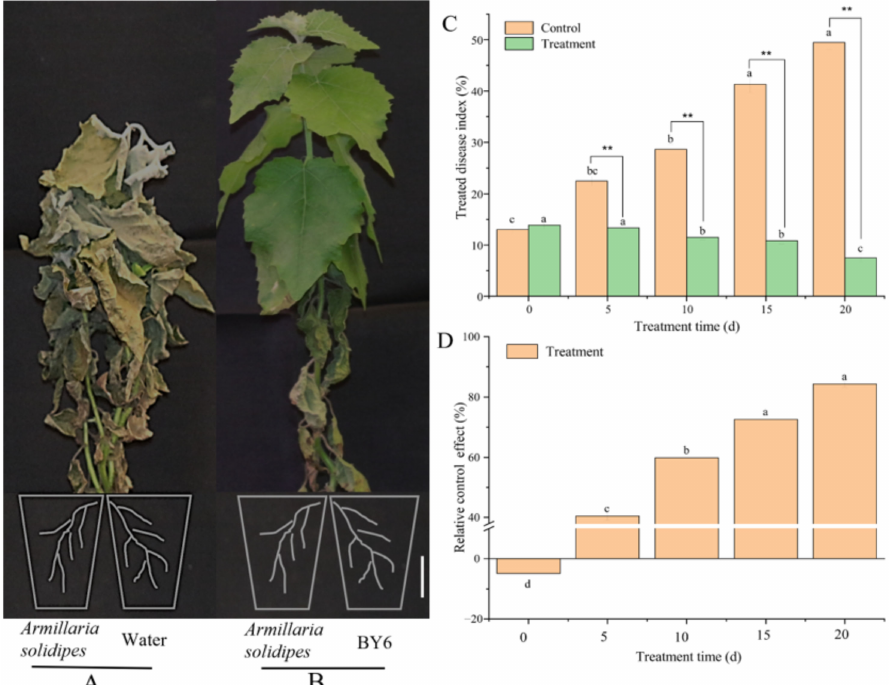
Figure 1. Pdpap poplar ARR symptoms and treated disease index. ( A ): Water control; ( B ): Inoculated BY6; ( A , B ): the inoculation of A. solidipes in advance 7 d, ( C ): the treated disease index; ( D ): Relative control effect; The roots of Pdpap poplar seedlings were divided into two equal parts (part 1 and part 2), and transplanted separately into two adjacent pots. Architect scale is 1 cm; The experiment was carried out in four biological replicates; ** indicate significant differences between the groups at the same time point (ANOVA, ** < 0.01), and the different lowercase letters indicate significant differences for the same treatment group at different times (ANOVA, p <